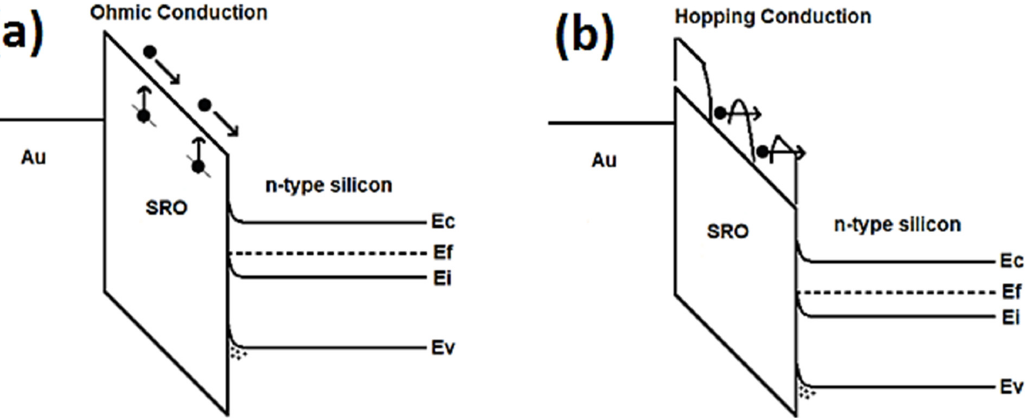
Figure 11. Energy band diagram of ohmic ( a ) and hopping conduction ( b ) in Au/SRO/Si structures.